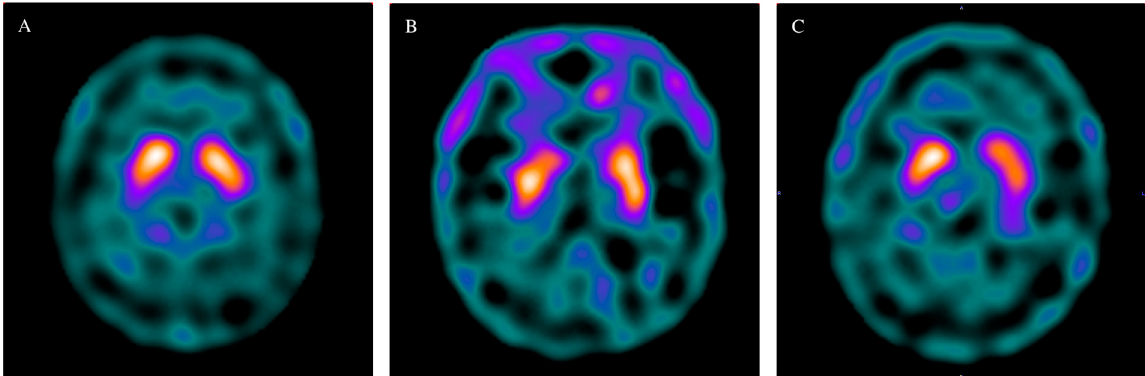
Figure 1. TRODAT ratio of the control ( A ), end stage renal disease (ESRD) without restless leg syndrome (RLS) ( B ) and ESRD with RLS ( C ) groups.